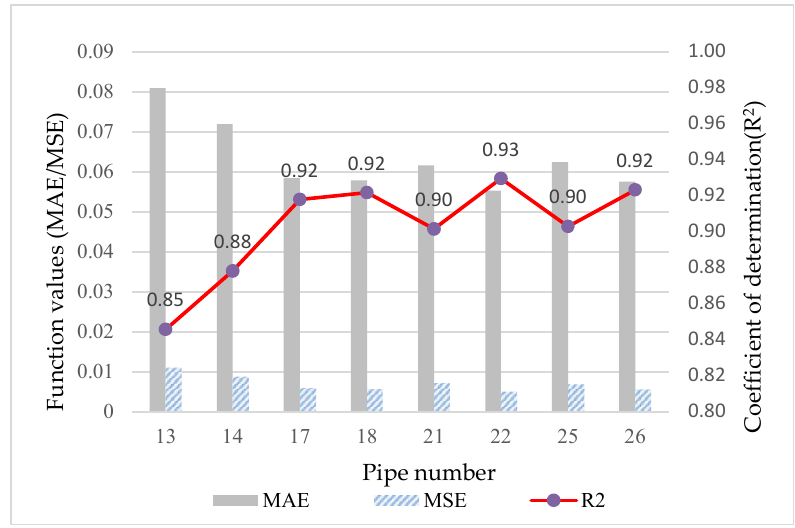
Figure 9. Second-stage LFD model performance in 100 sets of test experiments. Taking the pipe13 leakage model as an example, the experimental results are presented for one randomly selected group out of 100 test experiments. Figure 10 shows the exact leakage locations and the model-predicted leakage locations in the test set. Except for a few outliers, the majority of the predicted values are close to the actual values, and it can be intuitively inferred that the BP-neural-network-based second-stage LFD model is able to predict the pipe leakage location accurately. Thus, the second-stage LFD model has good diagnostic efficacy.